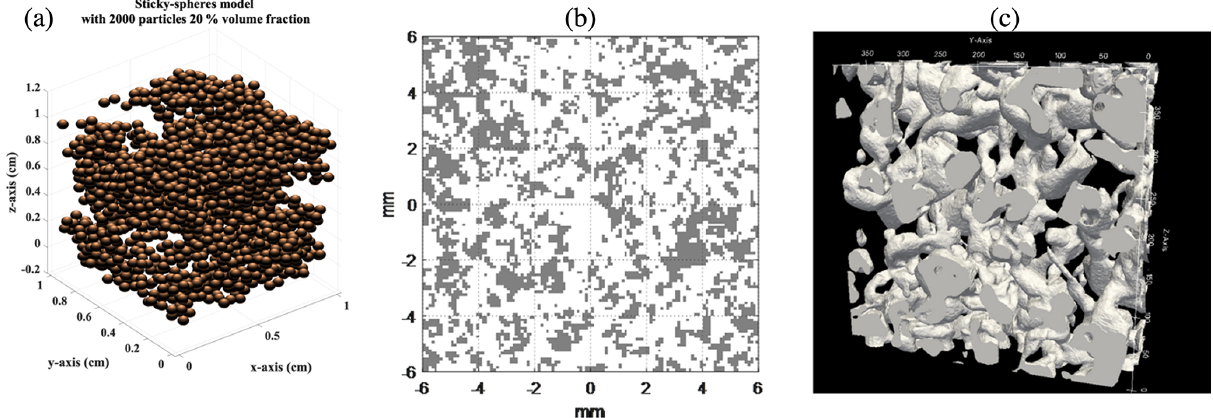
Figure 2. Microstructural descriptions of the snowpack: (a) sticky-hard-sphere theoretical model, (b) a bicontinuous medium with ice crystals in dark and air in white based on parameters (cid:104) ζ (cid:105) = 1mm and b = 1 . 0, and (c) 3-D image from X-ray microtomography with ice crystals shown in white and air voids in black.